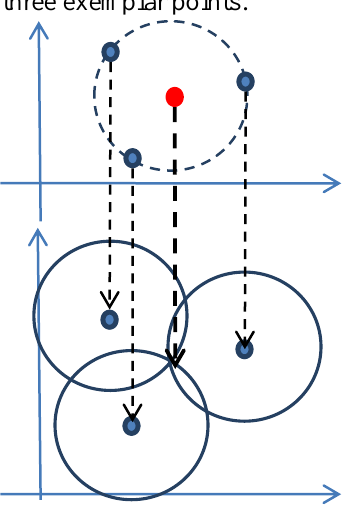
Figure 5. Each point in geometric space (up) generates a circle in parameter space (down). Circles in parameter space intersect at center in geometric space.